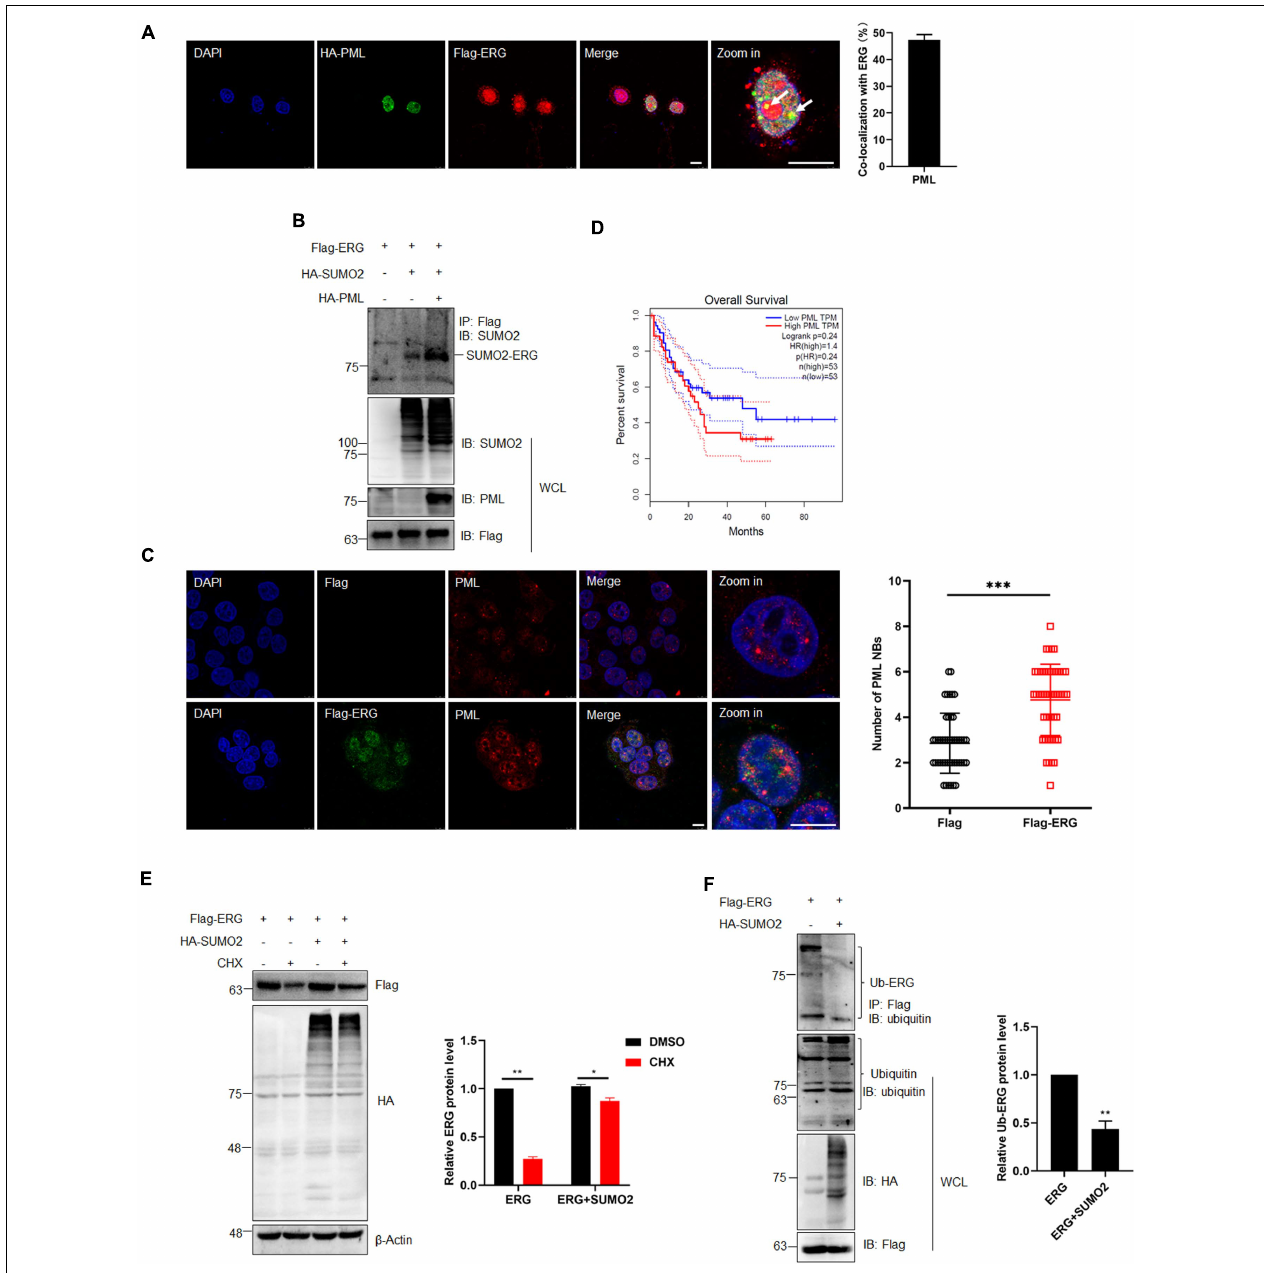
FIGURE 5 | PML recruited and enhanced the SUMOylation of ERG, and SUMOylation promotes the stability of ERG. (A) The localization of endogenous ERG and PML in the nucleus. HEK293T cell were cultured for immunocytochemistry with ERG (red) and PML (green) specific antibodies (left). The results of quantitative analysis of co-localization are shown in the right panel ( n = 3 repeats/group, Student’s t -test). DAPI (blue) was used to show nuclei. The scale bar is 10 µ m. (B) PML enhances the SUMOylation of ERG. The indicated plasmids were transfected into HEK293T cells, and the IP with FLAG from cell lysates were detected by IB with anti-SUMO2 antibody, and the WCL were detected by IB with anti-SUMO2, anti-PML, or anti-FLAG antibodies. (C) ERG promotes the formation of PML NBs. Flag-ERG and HA-PML plasmids were transfected into HEK293T cells, and harvested for immunocytochemistry staining with Flag (red) and PML (green)-specific antibodies (left). The results of quantitative analysis of co-localization are shown in the right panel ( n = 3 repeats/group, Student’s t -test, *** p < 0.001). DAPI (blue) was used to show nuclei. The scale bar is 10 µ m. (D) PML overexpression is not associated with prognosis. Patients whose ERG expression levels were one normalized standard deviation above and below the mean level were grouped as high ERG and low ERG, respectively. (E) SUMOylation promotes the stability of ERG. The indicated plasmids were transfected into HEK293T cells, and cells were treated with CHX for 6 h. The transfected cells were harvested and the cell lysates were detected by IB with anti-HA, anti-Flag, or anti- β -actin antibodies (left). The results of quantitative analysis of Western blot are shown in the right panel ( n = 3 repeats/group, two-way ANOVA, * p ( < 0.05, ***p ( < 0.001). (F) SUMOylation inhibited the ubiquitination of ERG. FLAG-ERG and HA-SUMO2 plasmids were transfected into HEK293T cells, and the IP with Flag from cell lysates were detected by IB with anti-ubiquitin antibody. The WCL were detected by IB with anti-ubiquitin, anti-HA, or anti-Flag antibodies (left). The results of quantitative analysis of Western blot are shown in the right panel ( n = 3